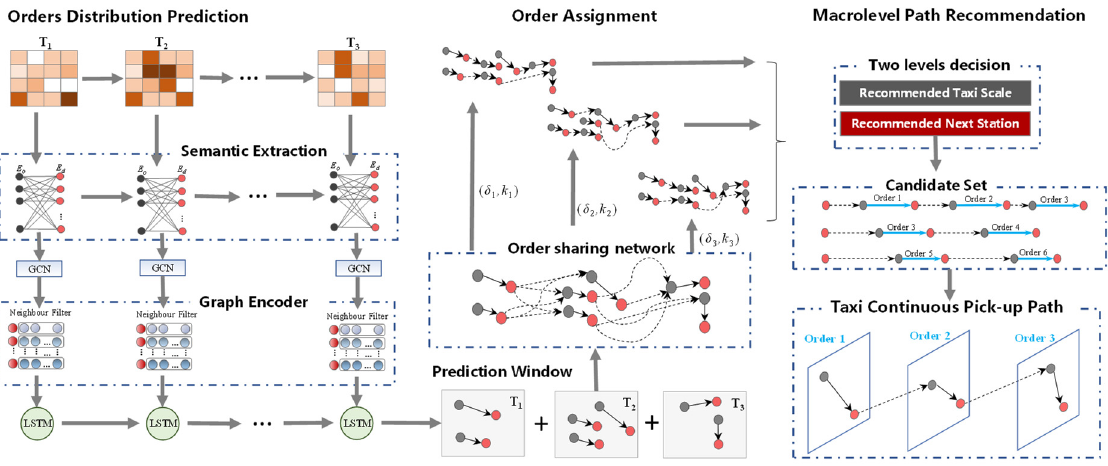
Figure 3. The overall architecture for continuous taxi pickup path planning guided by trajectory sharing.